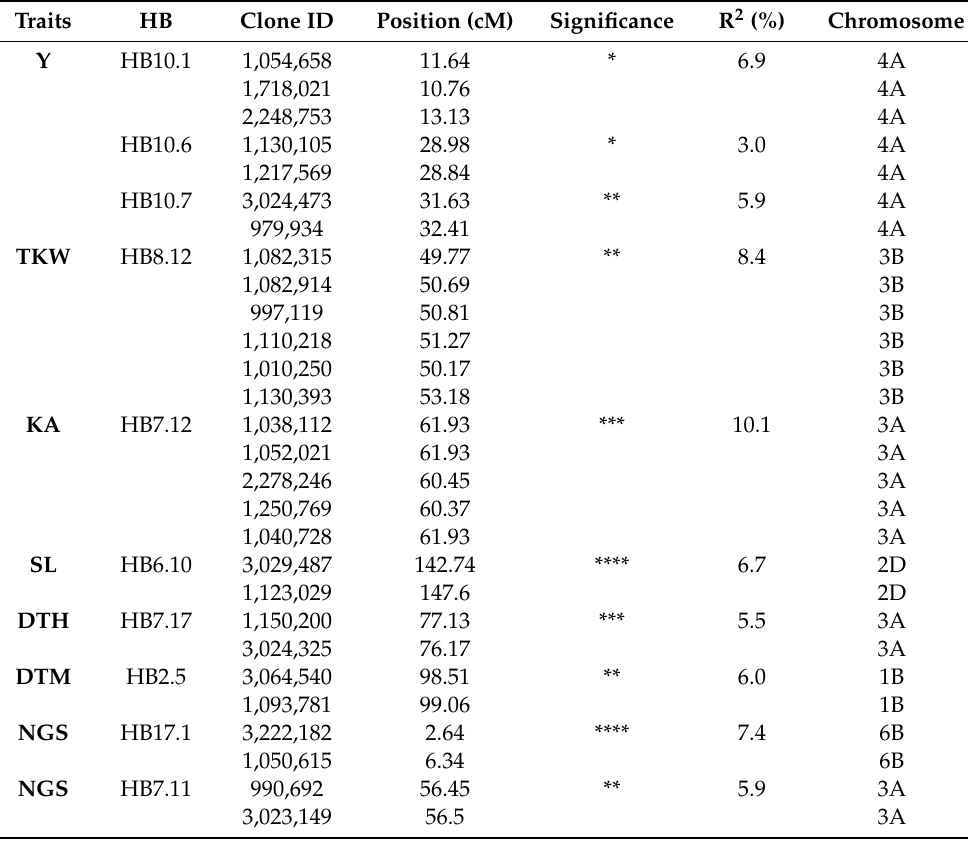
Table 3. Association of haplotype blocks with grain yield and related traits under terminal stage drought stress in wheat.